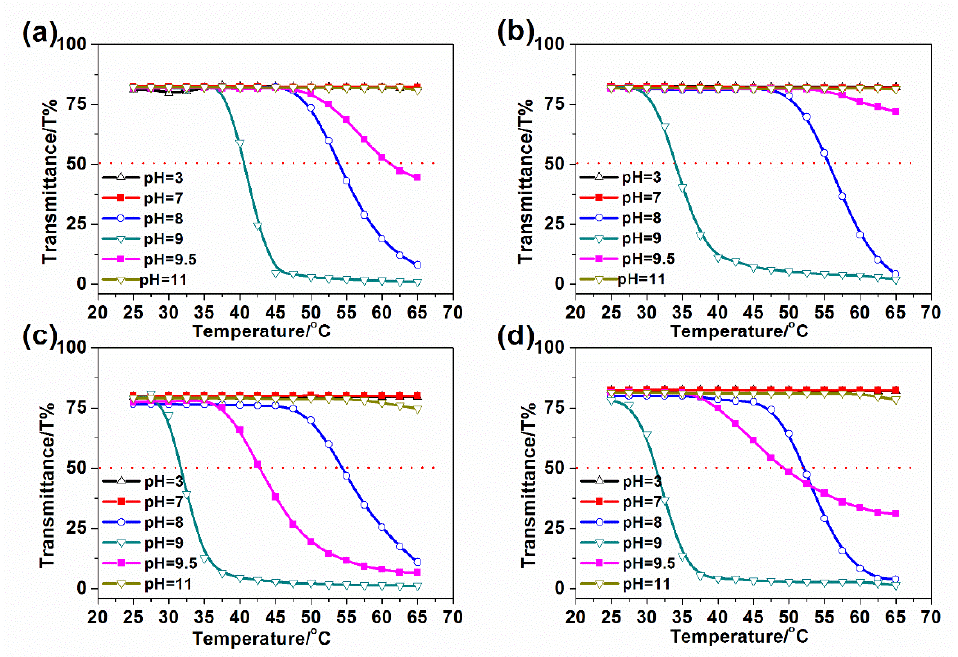
Figure 7. The effect of the pH value of 1.0 mg mL − 1 aqueous solutions of 4-arm star-PAA 1 - b - PDMAEMA 4 ( a ), 4-arm star-PAA 2 - b -PDMAEMA 4 ( b ), 4-arm star-PDMAEMA 4 - b -PAA 1 ( c ) and 4-arm star-PDMAEMA 4 - b -PAA 2 ( d ) on the LCST and temperature curve when the transmittance of the solution was monitored at 500 nm at a heating rate of 0.5 °C min − 1 .